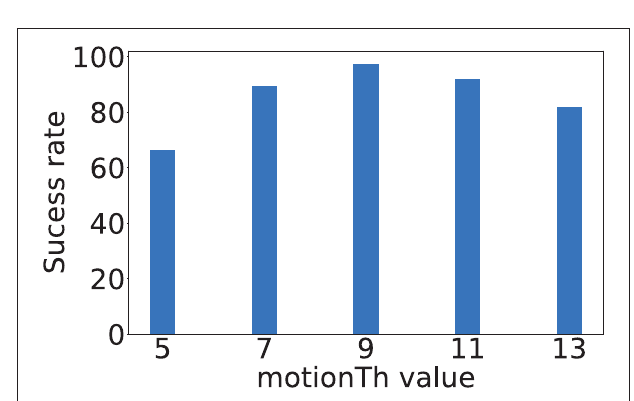
FIGURE 7 | Localization success rate for different sensor pairs. Blue, orange, and green bars represent results from Baseline 1, Baseline 2, and AutoLoc , respectively.